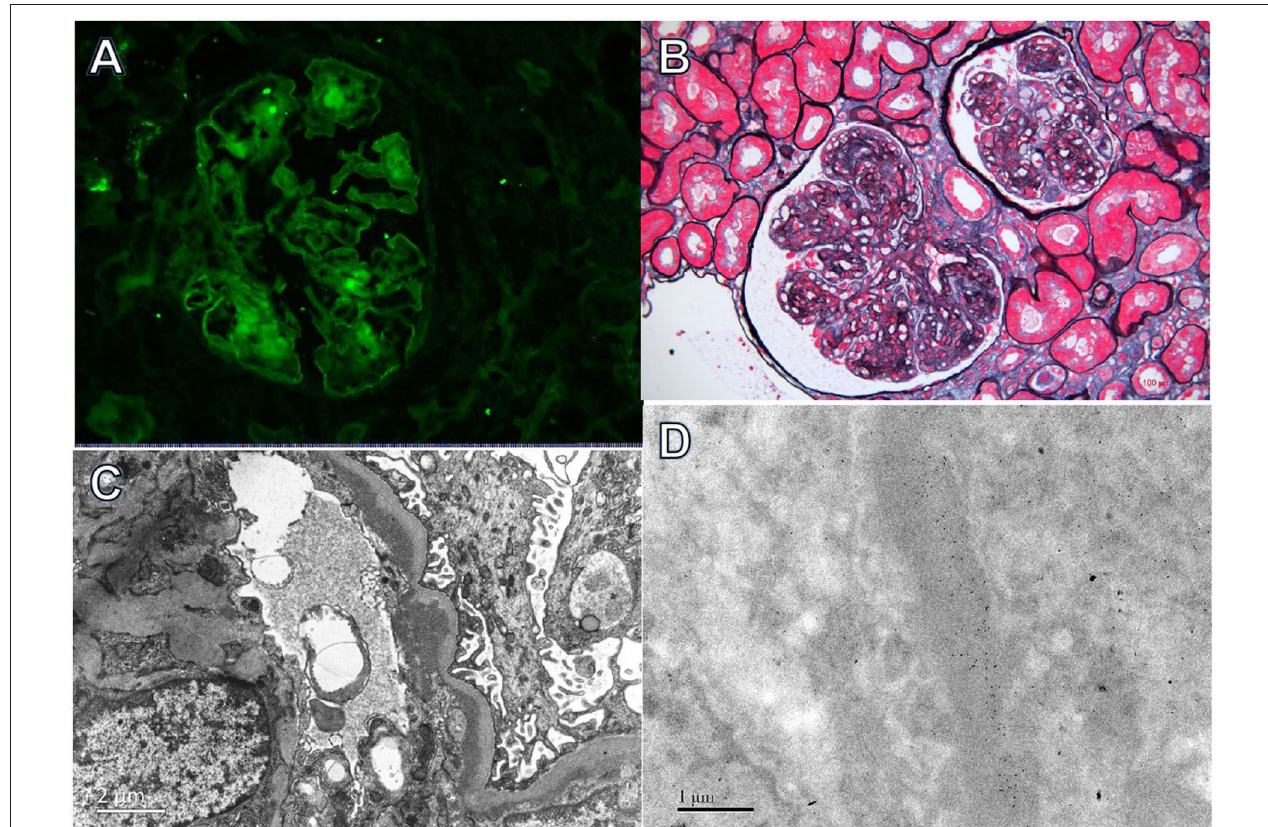
FIGURE 3 | Clinical course of Case 1. After treatment with lenalidomide, the renal impairment and proteinuria caused by LCDD was improved. BCD: bortezomib (2mg, once weekly), cyclophosphamide (200mg, once weekly), and dexamethasone (20mg, once weekly); Rd: lenalidomide (25mg daily, on Days 1 through 21 of each 28-day cycle) and dexamethasone (20mg once